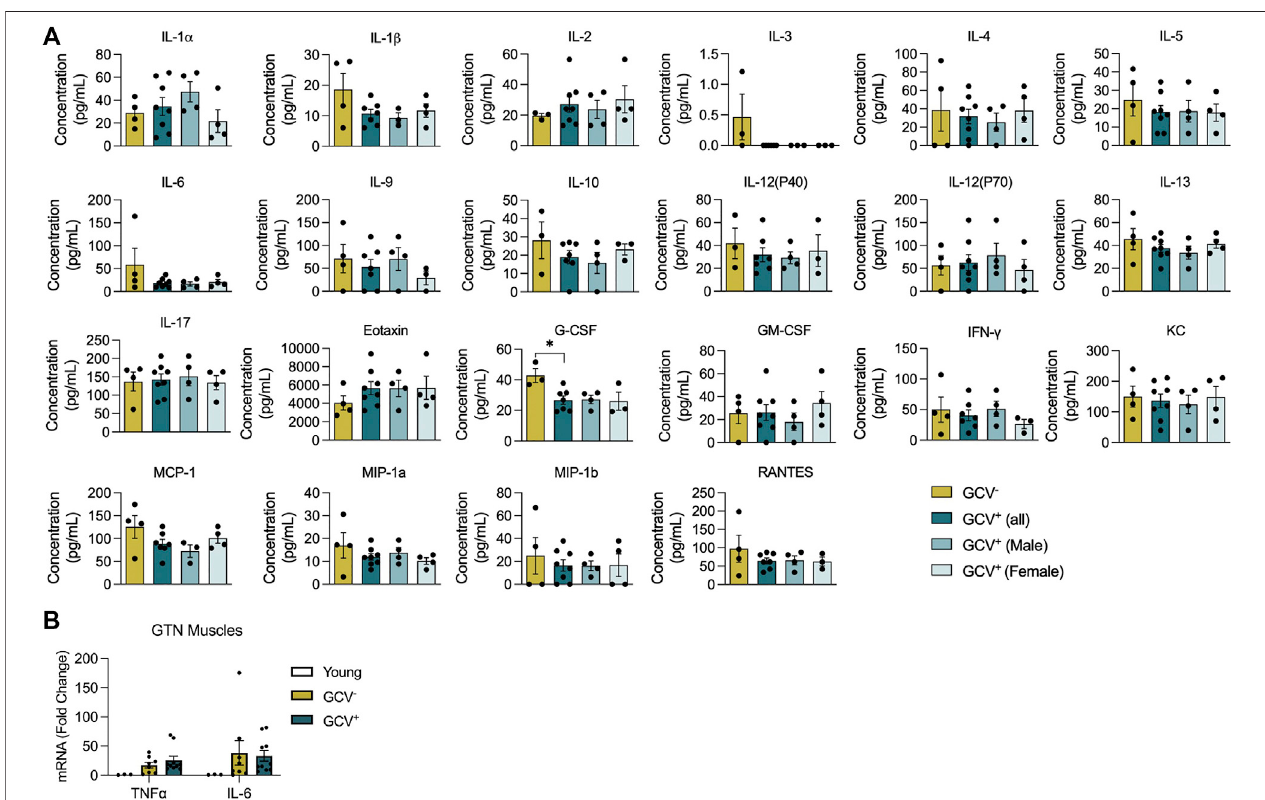
FIGURE5| Plasmain fl ammatoryfactorsandskeletalmusclecytokinemRNAexpressionwerelargelyunaffectedwithp16 - positivecelldeletion. (A) Plasmaprotein levels (pg/ml) for 22 in fl ammatory mediators are shown for saline treated controls (GCV − ), combined male and female GCV treated mice, GCV + (all), male GCV treated mice, GCV + (Male), and female GCV treated mice, GCV + (Female). (B) TNF α and IL-6 mRNA expression relative to 18s mRNA in gastrocnemius (GTN) muscles were not signi fi cantlydifferentinyoung,GCV − ,andGCV + mice.Barsshowthemean±SEMofthreetoeightmicepergroupwithdotsrepresentingdatafromeachindividual mouse. *Denotes p < .05 between groups by one-way